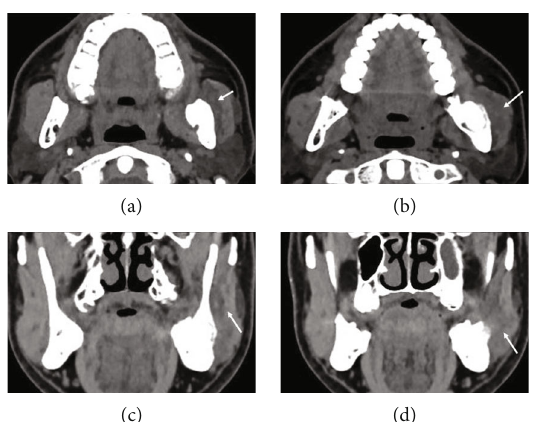
Figure 2: Case #1, soft tissue window CT images. Axial views (a – b) and coronal views (c – d) showing edema within the adjacent left masseter muscle (arrows).